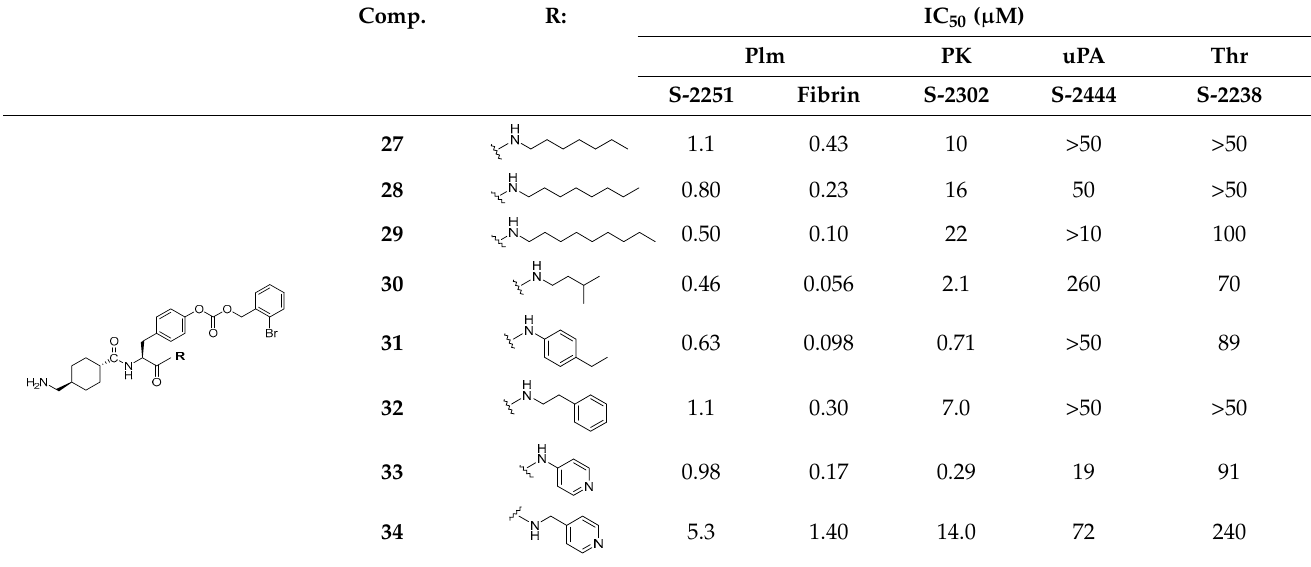
Table 7. Inhibitory activity of compounds 27–34 [31] against various proteases . Comp.